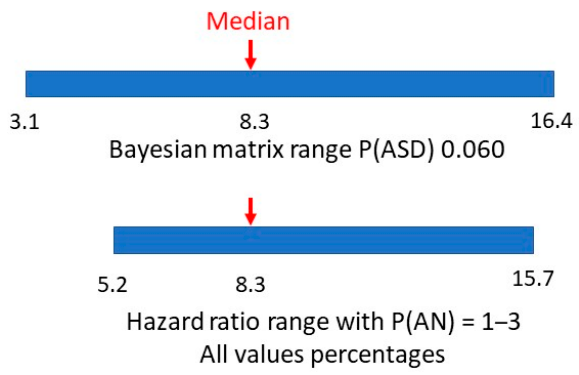
Figure 13. P(AN|ASD) revised Bayes’ matrix range. Figure 14. P(AN|ASD) revised Bayes’ matrix